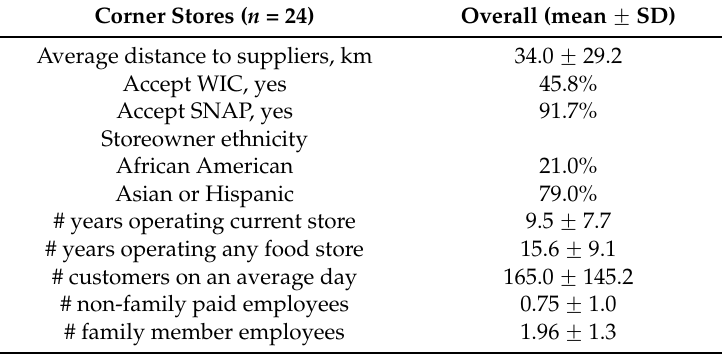
Table 1. Summary characteristics of sampled corner stores in Baltimore City, MD.